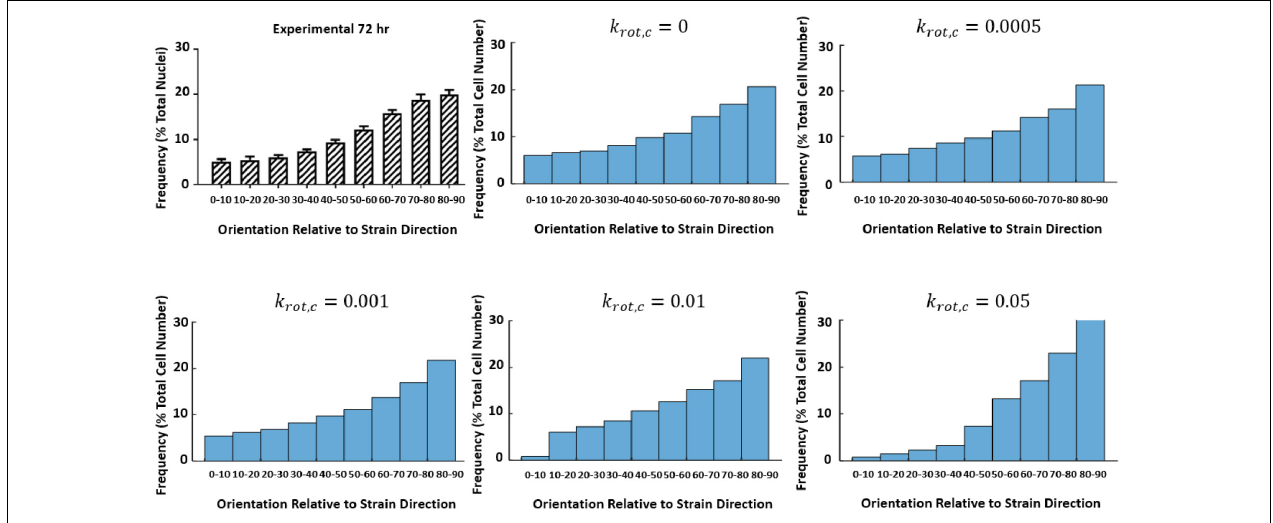
FIGURE 9 | Influence of k rot , c on cell reorientation (Mathieu, 2020; Mathieu et al., 2020).